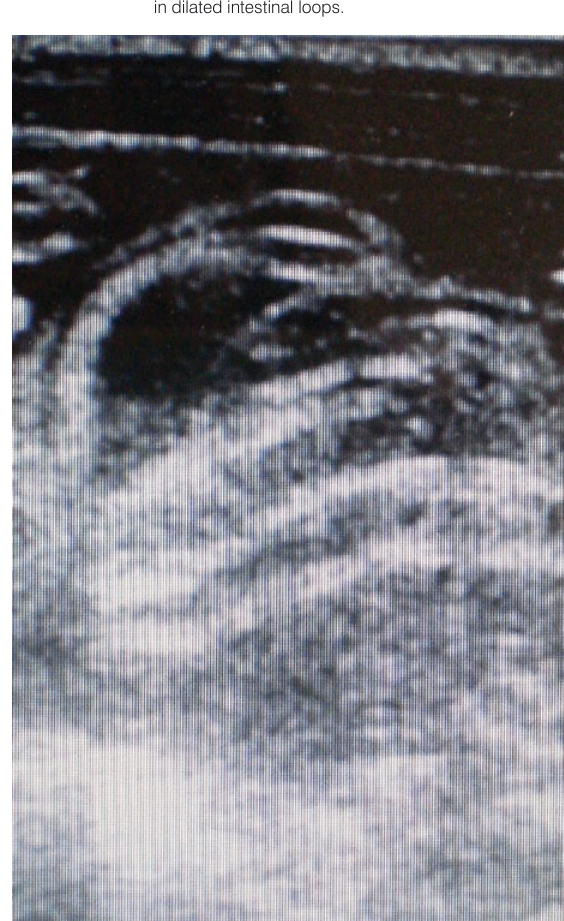
Figure 1. Ultrasonographic appearance of multiple longitudinal curvilinear echogenic strips with a central anechoic linear area, which corresponds to Ascaris lumbricoides in dilated intestinal loops.